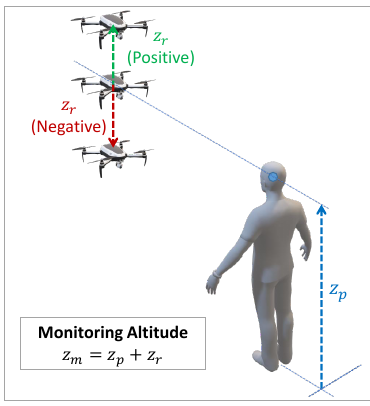
Figure 1. 3D representation in isometric perspective of the UAV’s monitoring altitude, z m , which is determined by the person’s height, z p , plus the relative monitoring altitude, z r .